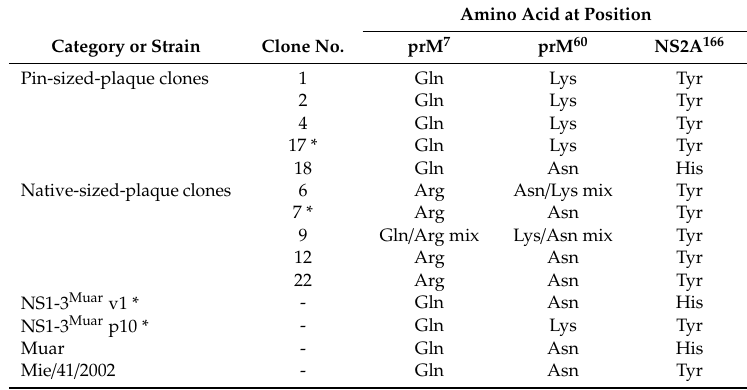
Table 1. Amino acid residues that di ff er among amino acid sequences of NS1-3 Muar strains. Amino Acid at Position Category or Strain Clone No. prM 7 prM 60